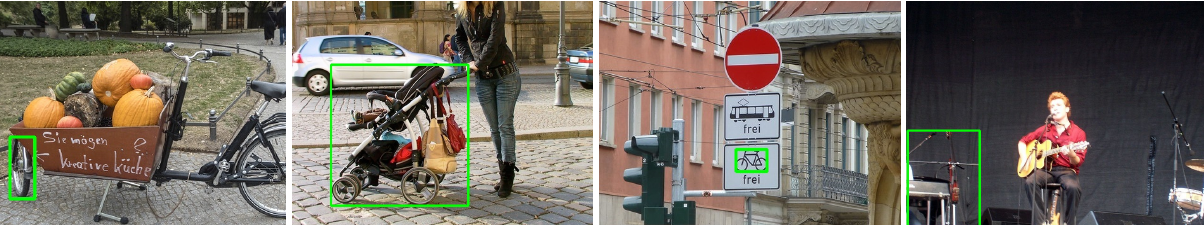
Figure 7. Most common cases of false positives, i.e., wrongly detected bicycles, from left to right: smaller parts of complete bicycles; other wheeled objects such as baby strollers, wheelchairs and motorcycles; traffic signs with bicycle pictograms; miscellaneous objects such as musical instruments, chairs and camera